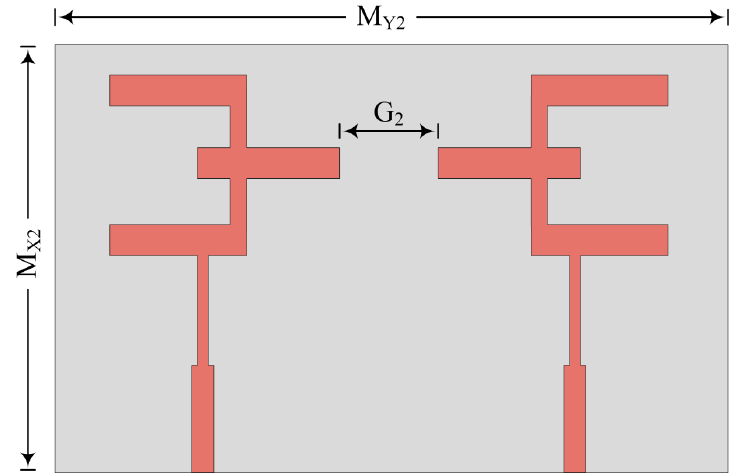
Figure 9. Schematic of MIMO antenna for inverted parallel placement of elements.